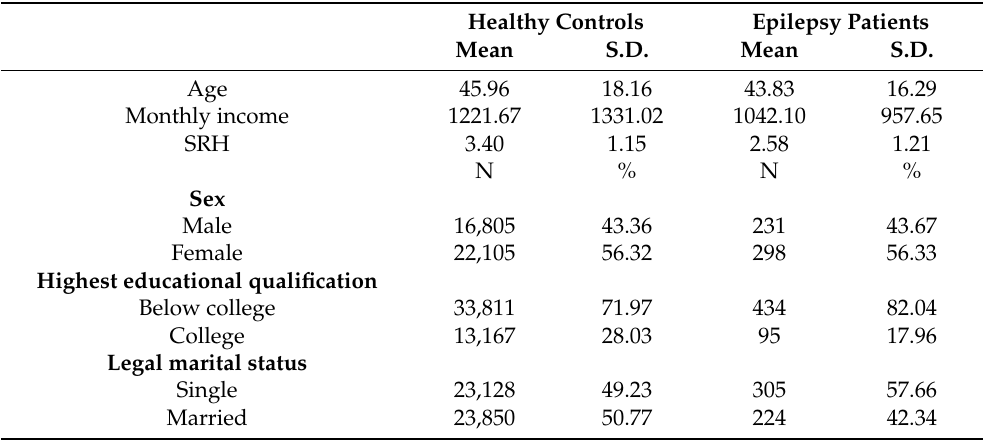
Table 1. Descriptive statistics of demographic characteristics, epilepsy status, and SRH (self- rated